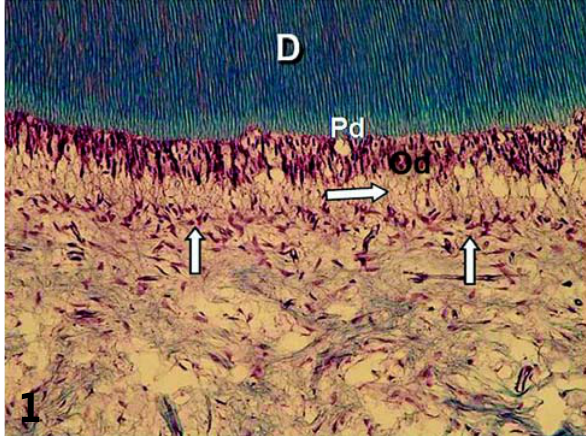
FIGURE 1- General view of the dentin-pulp complex. Below the tubular dentin (D) there is the predentin (Pd), which is underlined by the odontoblast layer (Od). Observe the cell- free zone of Weil – horizontal arrow) and the cell-rich zone (vertical arrows). HE, ×64